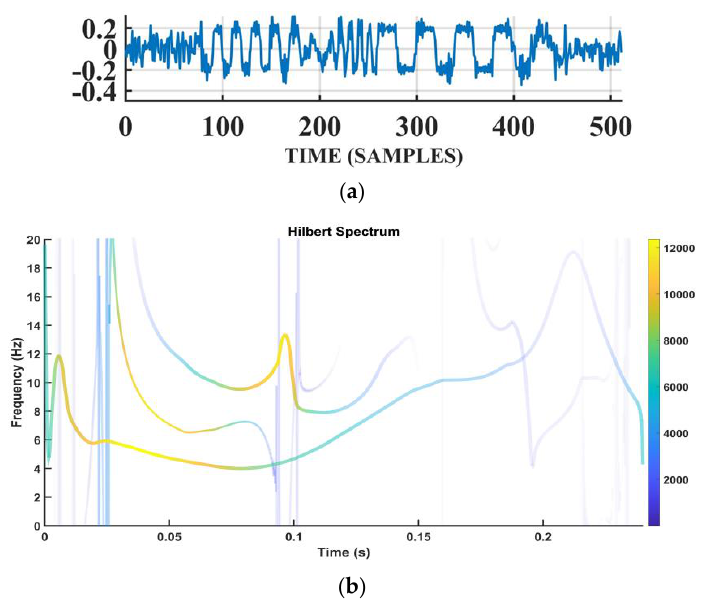
Figure 13. ( a ) generated CCHIF voltage waveform, ( b ) Hilbert Spectrum of CCHIF waveform.